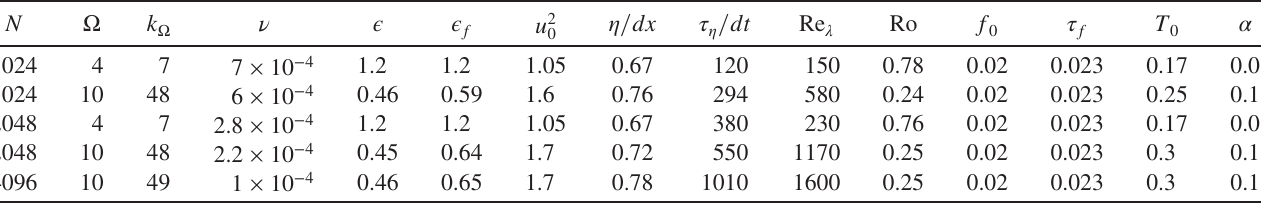
R P d 3 x f u f ¼ i i , energy i